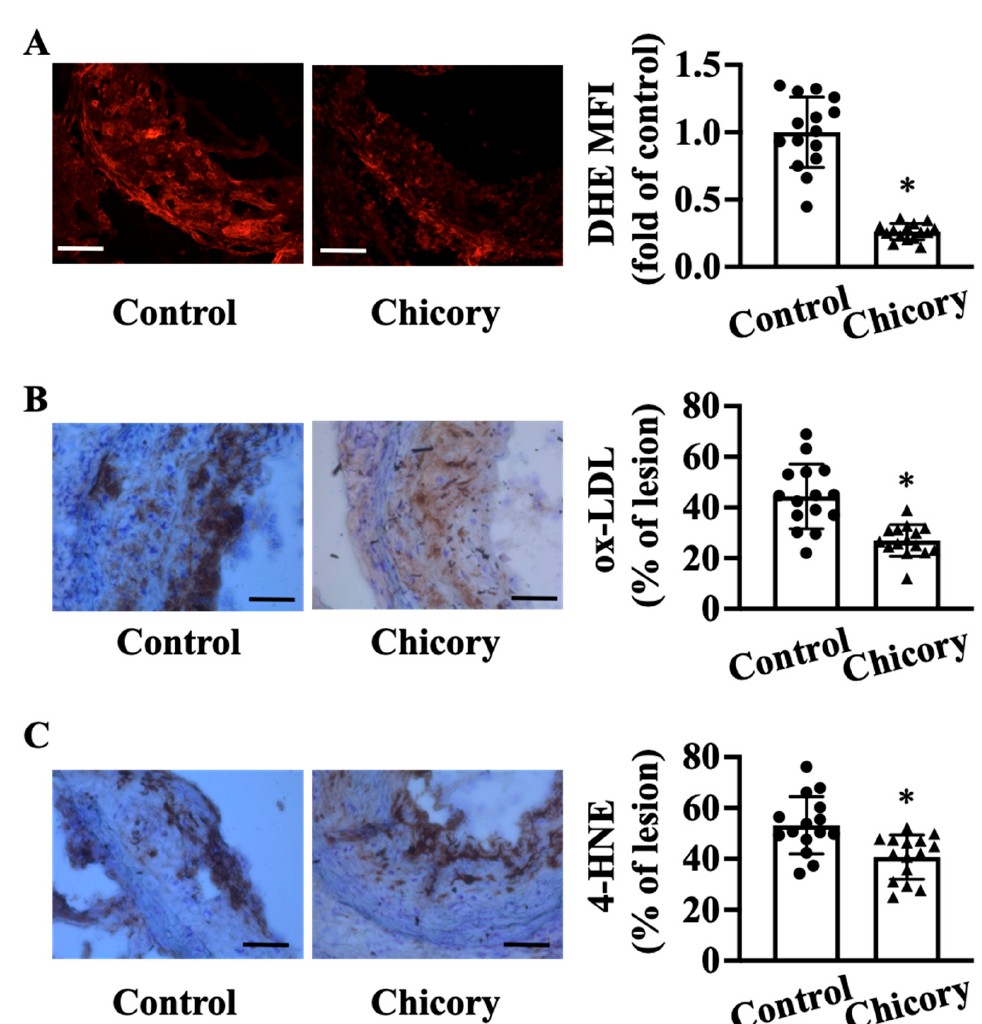
Figure 4. Brussels chicory consumption improves oxidative stress in atherosclerotic plaques in Apoe − / − mice. ( A ) Representative images of dihydroethidium (DHE) staining (left panel) and quantification of the fluorescence signals (right panel) in plaques of the aortic root. Scale bars: 100 µ m. ( B , C ) Representative immunohistochemistry images of oxidative products ox-LDL (( B ), left panel) and 4-HNE (( C ), left panel) in aortic root sections and quantification of the ox-LDL (( B ), right panel) and 4-HNE positive area (( C ), right panel). Scale bar, 100 µ m. Data are presented as means ± SD. n = 15. * Significantly different from the control group ( p < 0.05). Apoe, apolipoprotein E; Chicory, Brussels chicory; MFI, mean fluorescence intensity.